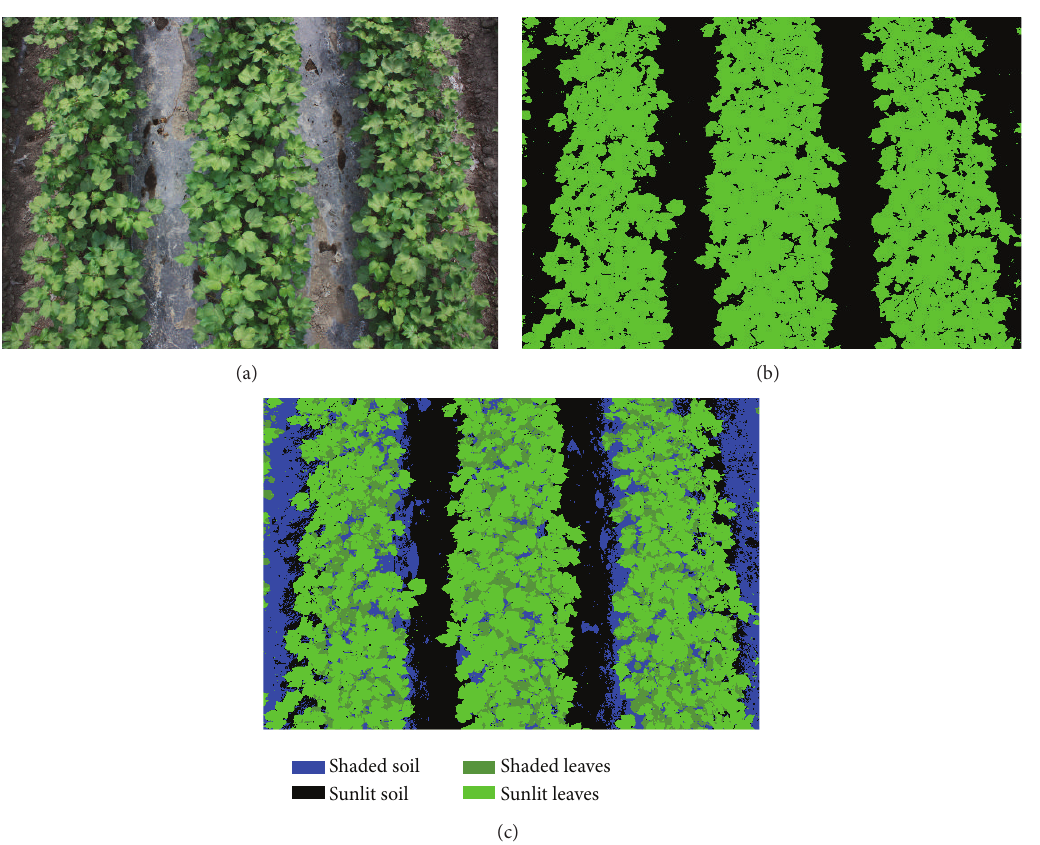
Shaded leaves Sunlit leaves